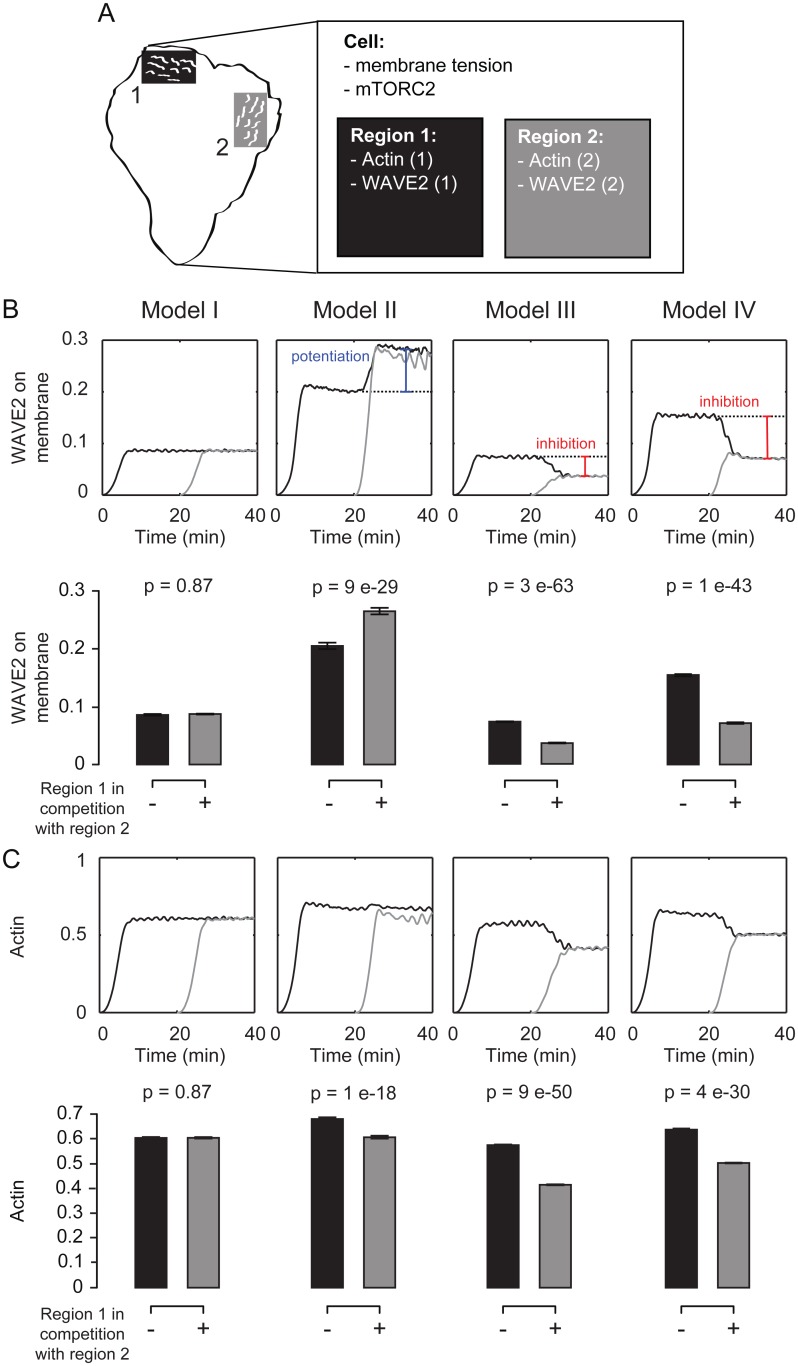
Simulated competition between two nucleating regions that share membrane tension.(A) Schematic of competition simulations. We simulated the response of two spatially separate sites of actin assembly that are linked via membrane tension. The two regions each have individual dynamics of actin polymerization and WAVE2 membrane binding but are coupled via cellular membrane tension and level of mTORC2 activity. (B,C) Quantification of time-varying (graphs) and time-averaged (bar plots) WAVE2 complex (B) and polymerized actin (C) at the membrane. A site of actin nucleation (number 1) starts alone, but is then placed in competition with a second site of actin nucleation (number 2). Mean ± SD of 20 stochastic simulations. Only Models III and IV show competition between protrusions at the level of WAVE2 complex recruitment. See S8 Fig for how competition affects the Wave Index. Statistics: t test.